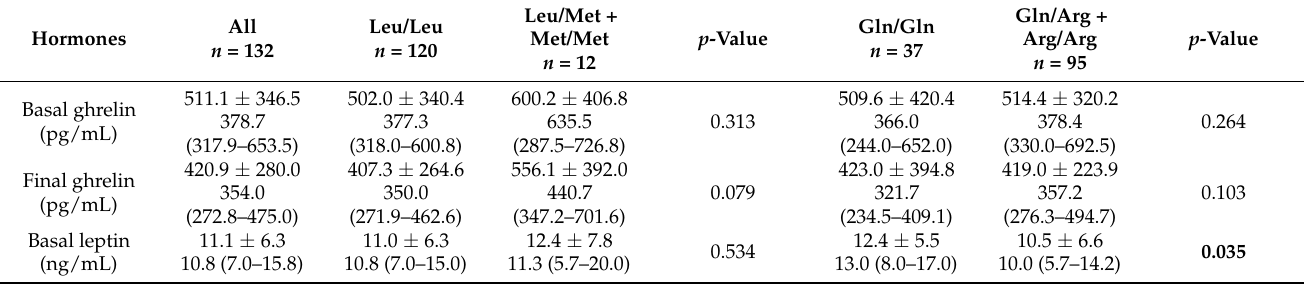
Table 4. Serum levels of appetite hormones analyzed for association with Leu72Met of GHRL and Gln223Arg of LEPR